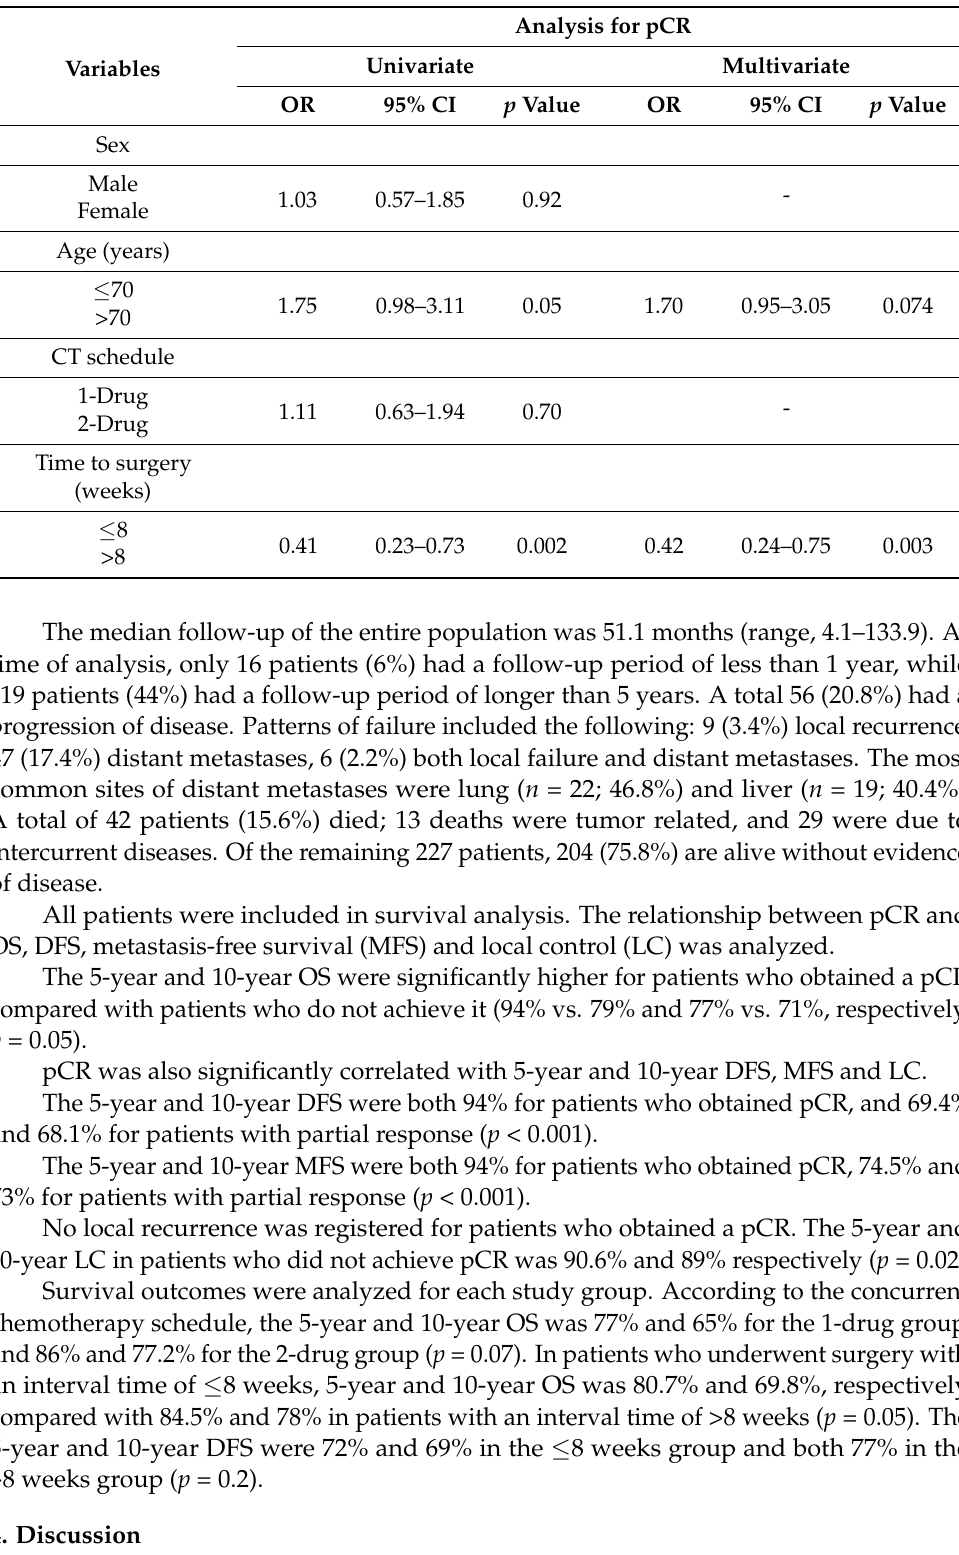
Table 8. Results of univariate and multivariate analysis for